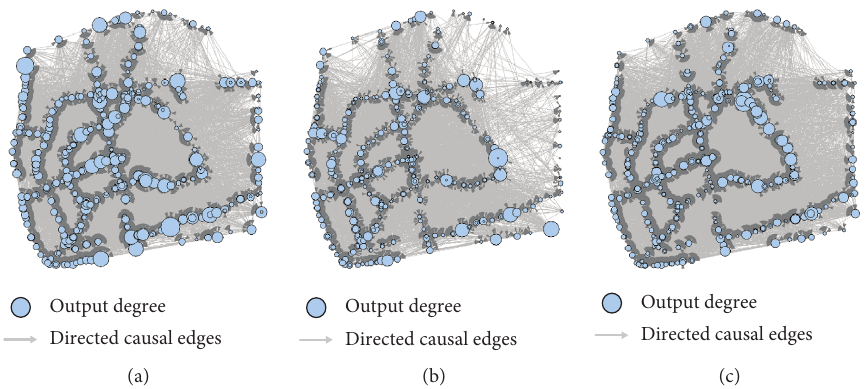
Figure 14: Visualization of spatiotemporal traffic causality graphs: (a) morning peak time; (b) nonpeak time; (c) evening peak